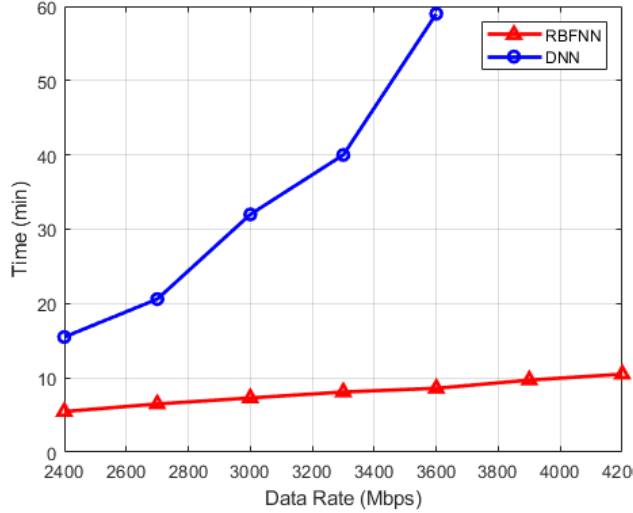
Figure 19. Simulated results of training time vs. data rate with RBFNN or DNN as equalizer.